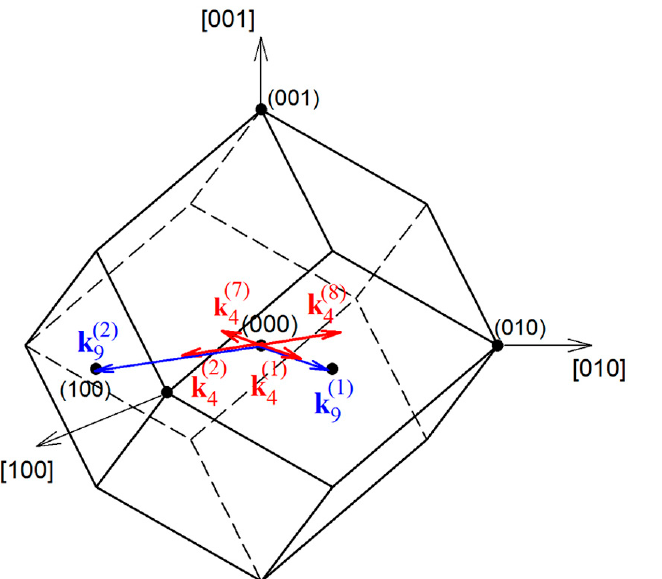
( 1 ) ( 2 ) ( 1 ) ( 2 ) ( 7 ) ( 8 ) , k , k , k , k and k of the 9 9 4 4 4 4 )1( k , )2( k , )1( k , )2( k , )7( k , and )8( k of 9 4 4 9 4 4